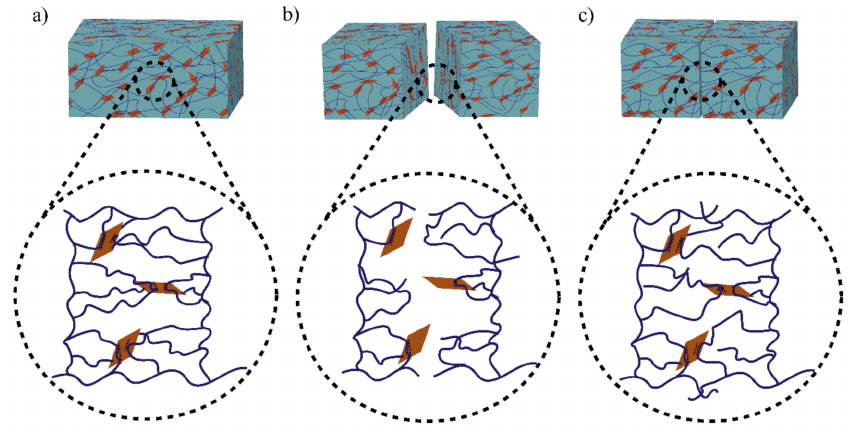
Figure 1. Illustration of the healing mechanism of functionalized graphene oxide crosslinked poly- acrylamide hydrogel. Bonding mechanism of ( a ) fresh hydrogel sample, ( b ) cut sample, and ( c ) healed sample. The polymer chains (line) undergoe reversible dynamic hydrogen bonding with the polar OH groups of GO surfaces (rectangle